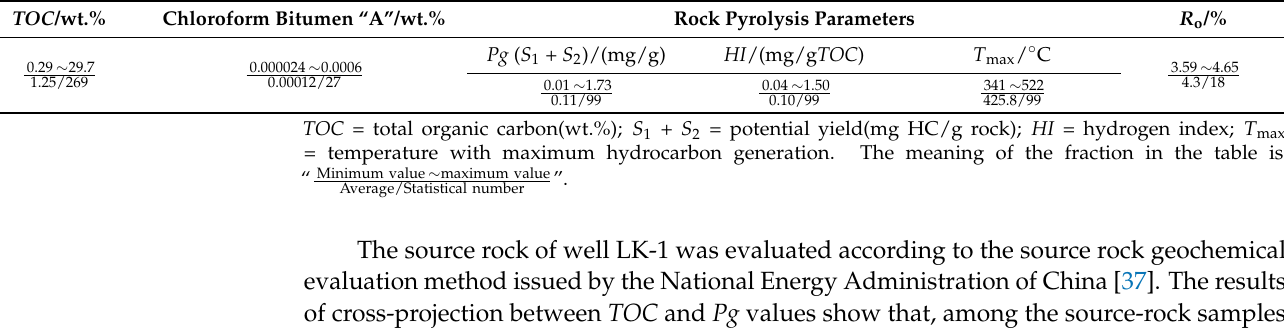
Table 1. Geochemical data of over-mature source-rock samples in well LK-1. TOC /wt.% Chloroform Bitumen